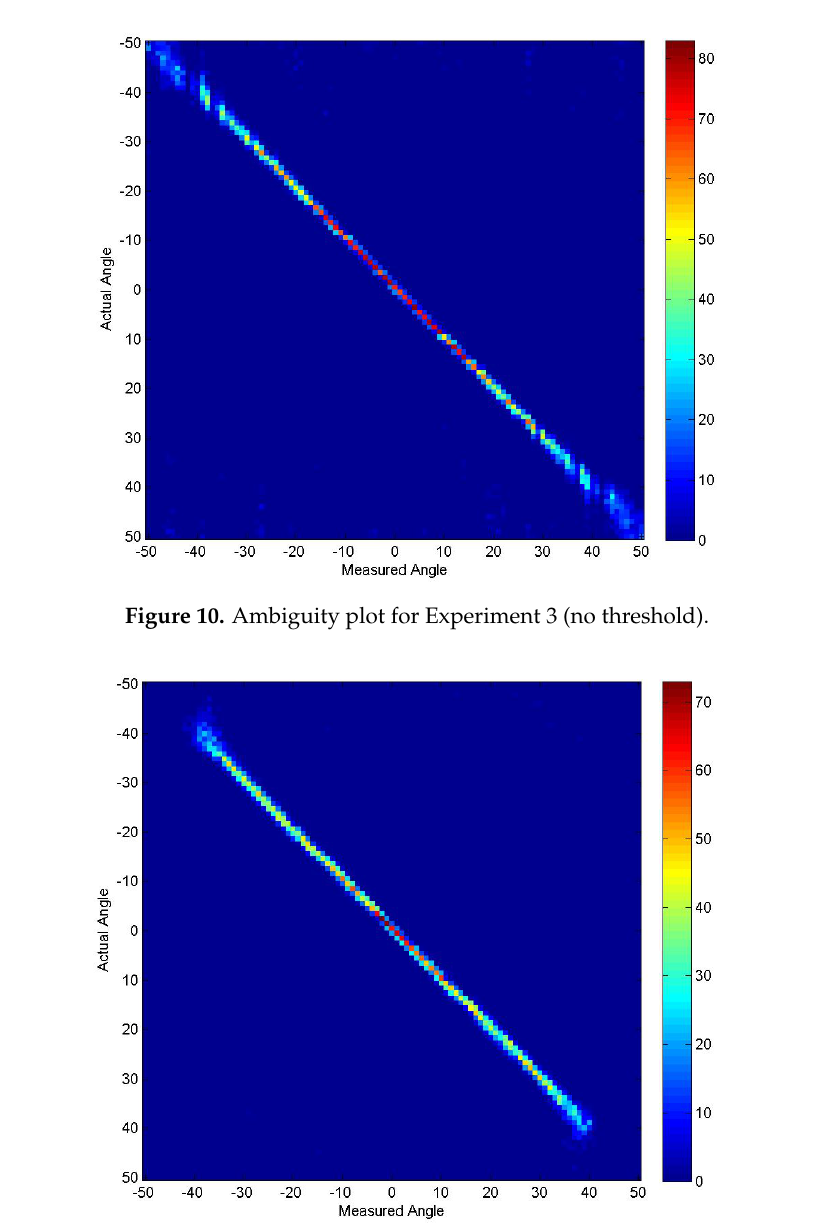
Figure 11. Ambiguity plot for Experiment 3 (13-dB